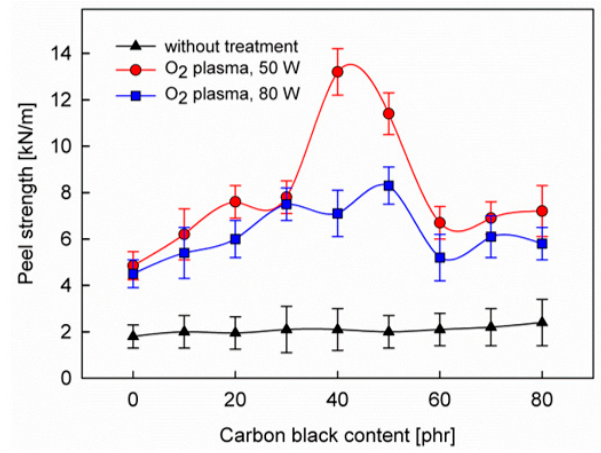
Figure 1. Peel strength test for the SBS rubber with various carbon black content, before and after plasma treatments.